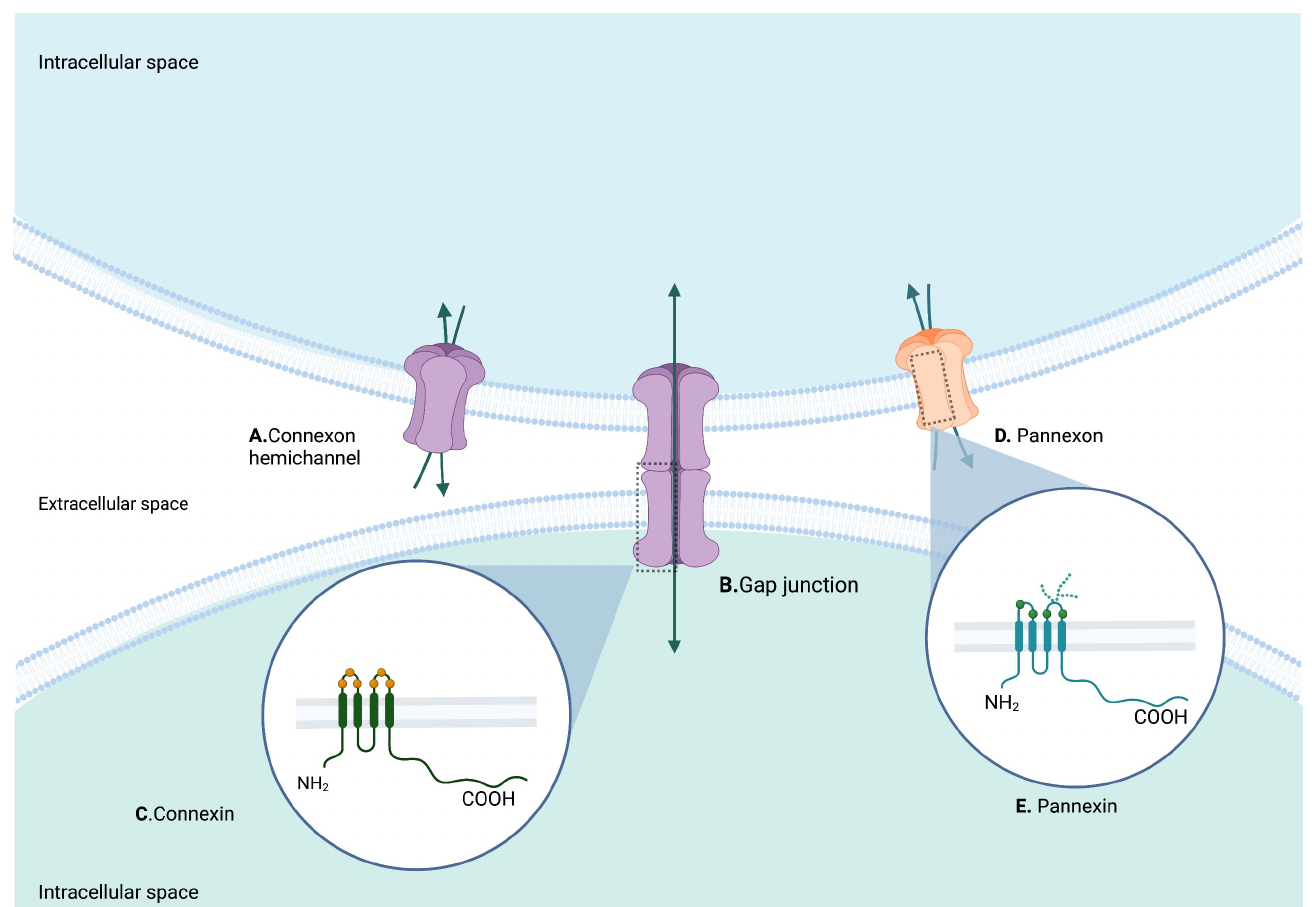
Figure 3. Structure representation of Cxs, Panxs, connexons, pannexons and gap junctions. (A) Oligomerization into hexamers of Cxs forming a connexon, or hemichannel, that allows the flow of small molecules. (B) Two connexons joined together forming a gap junction, allowing communication between two cells (C) Cxs have 4 transmembrane domains, cytosolic N-(amino) and C-(carboxyl) termini, two extracellular loops and one intracellular loop. They have 3 cysteine residues in each extracellular loop. (D) Pannexons formed by Panx1 have recently been found to oligomerize into heptameres. (E) Panxs consist of 4 transmembrane domains, with 2 extracellular loops, a cytoplasmatic loop, and cytosolic N-and C-termini. Panxs have 4 conserved cysteines ‒ two in each extracellular loop ‒ and they exhibit glycosylation of the first extracellular loop in Panx2 (not shown) and the second in Panx1 (shown). Created with BioRender.com. Accessed on 1 August 2022.